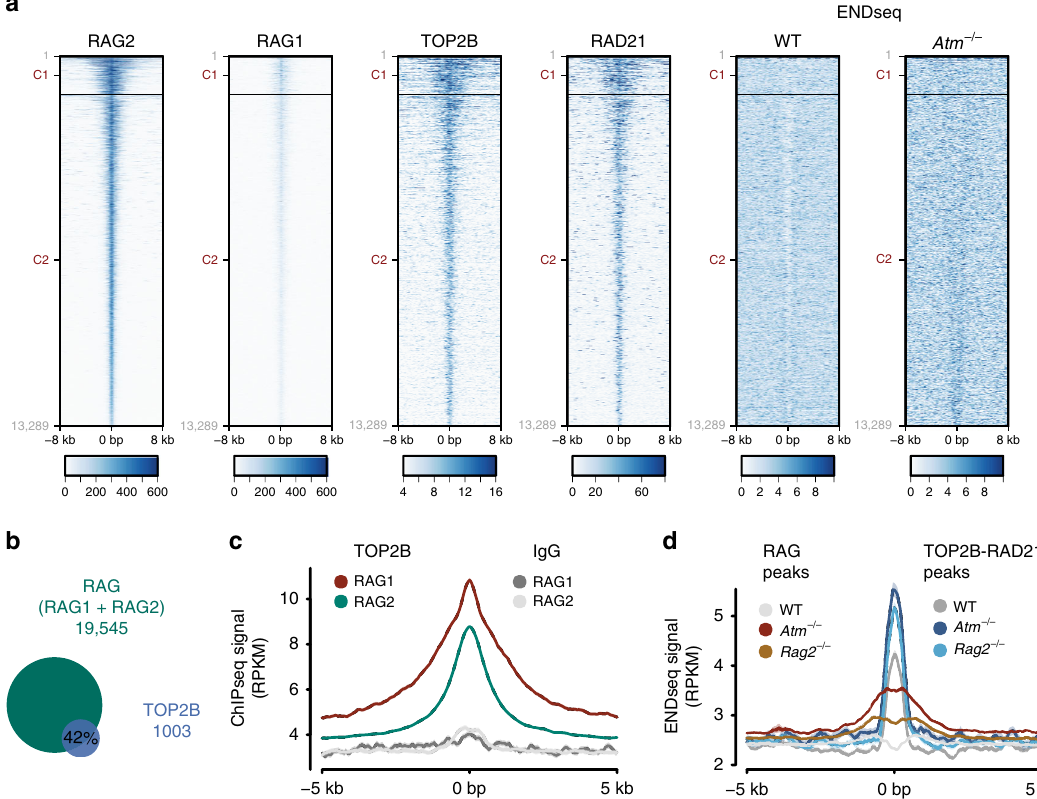
Fig. 6 TOP2B and cohesin colocalize with RAG genome-wide. a Heatmaps of RAG2 40 , RAG1 40 , TOP2B, RAD21 and ENDseq (DSBs) signal at RAG1 and RAG2 peaks (merged) in wild-type and Atm − / − primary thymocytes, as indicated. K-means clusters based on RAG1 and RAG2 signal are shown as C1 and C2. b Overlap of TOP2B and RAG peaks. Peaks of the RAG complex were de fi ned as a merge of RAG1 and RAG2 proteins. c Global pro fi le of TOP2B signal at RAG1 or RAG2 peaks. Control IgG signal is also shown. d Global pro fi le of ENDseq signal at either RAG (merge of RAG1 and RAG2 peaks) or TOP2B- RAD21 (overlap between TOP2B and RAD21) peaks in wild-type, Atm − / − and Rag2 − / − primary